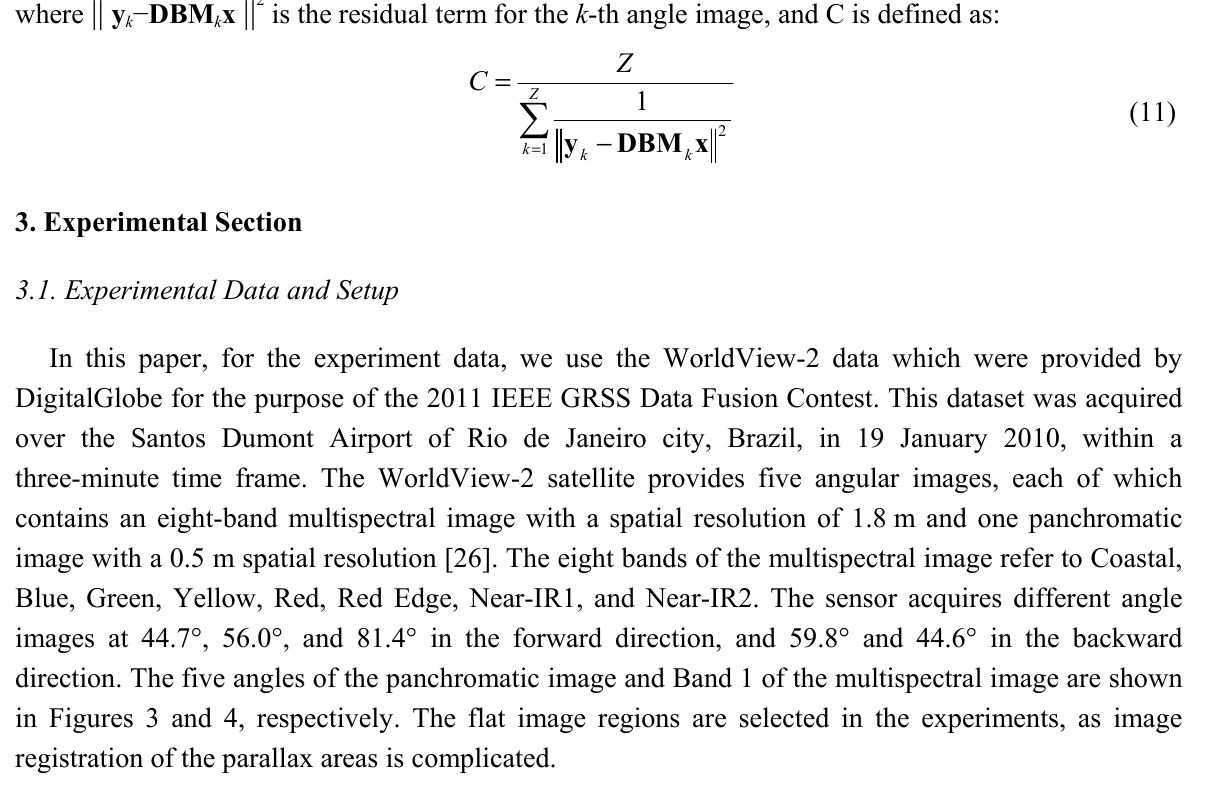
Figure 3. Panchromatic image of the multi-angle WorldView-2 imagery. From ( a ) to ( e ): 81.4° in the forward direction, 59.8° and 44.6° in the backward direction, and 44.7° and 56.0° in the forward